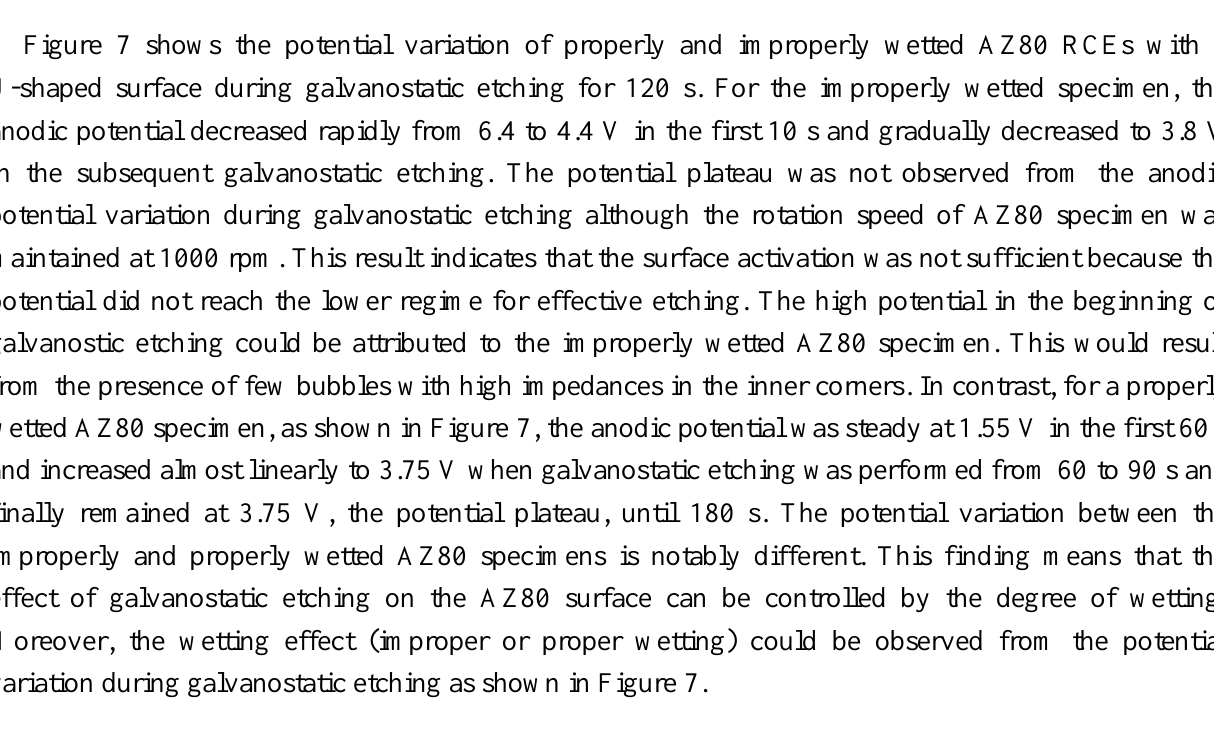
Figure 7. Potential variation of improperly and properly wetted AZ80 specimens with a U-shaped surface at a rotation speed of 1000 rpm during galvanostatic etching at the current density of 20 mA·cm −2 in an alkaline Cu-plating